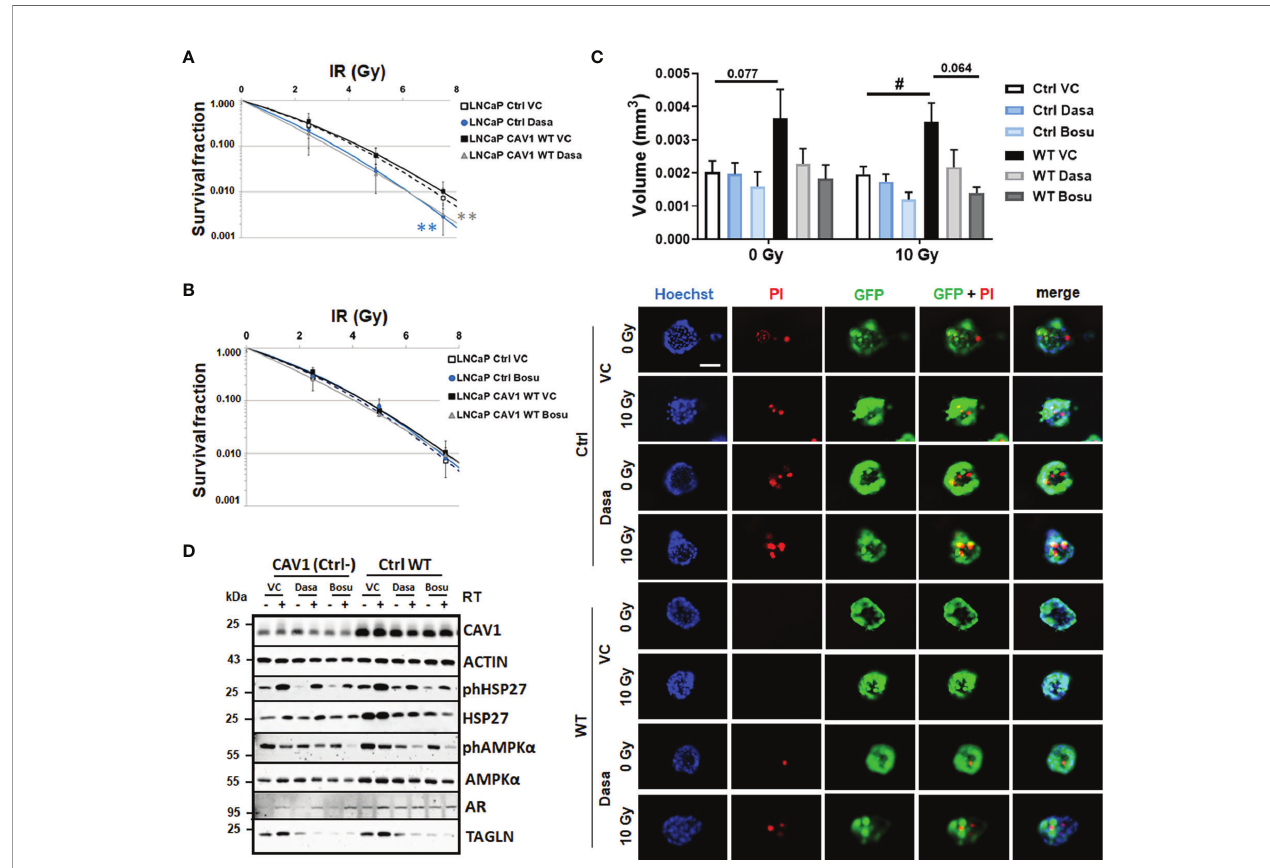
FIGURE 4 | SRC inhibition by dasatinib ef fi ciently reduces the clonogenic survival of LNCaP cells with differential CAV1 levels and also reduces three-dimensional PCa cell growth. LNCaP PCa cells stably overexpressing the introduced WT CAV1 and control (Ctrl) LNCaP cells with low endogenous CAV1 levels were cultured in normal growth media supplemented with the SRC inhibitors dasatinib, bosutinib or vehicle control (VC) 2 h prior radiation treatment with the indicated doses (0 – 7.5 Gy). Clonogenic survivals were evaluated 10 days post treatment with dasatinib (A) or bosutinib ( B ). Coomassie stained colonies were quanti fi ed by counting. Data show the surviving fractions from at least 3 independent experiments (means ± SD) plated in triplicates each. P-values indicate: **p ≤ 0.01 by one-way ANOVA with Tukey ’ s multiple comparison post-test. (C) Growth patterns of CAV1 WT and control LNCaP spheroids were evaluated 48 h post RT (10 Gy) and combined dasatinib treatment. Graphs depict the measurements from 4 to 6 independent experiments where at least 10 spheroids per condition (and per experiment) were measured. P-value indicates: # p ≤ 0.05 by unpaired (two-tailed) t-test. Cell death was analyzed afterwards by fl uorescence microscopy using propidium iodide. Hoechst 33342 was used for nuclei staining. Representative fl uorescent photographs from CAV1 WT and Ctrl LNCaP cells (with low endogenous CAV1 levels) are shown (48-hour time point). Scale bar represents 100 µm. (D) Expression levels of the indicated proteins were analyzed in whole protein lysates of cultured CAV1 WT and control LNCaP PCa with or without radiation and SRC inhibitor (dasatinib and bosutinib) treatment (48 h after RT with 10 Gy) using Western blot analysis. Representative blots at least 3 – 4 independent experiments are